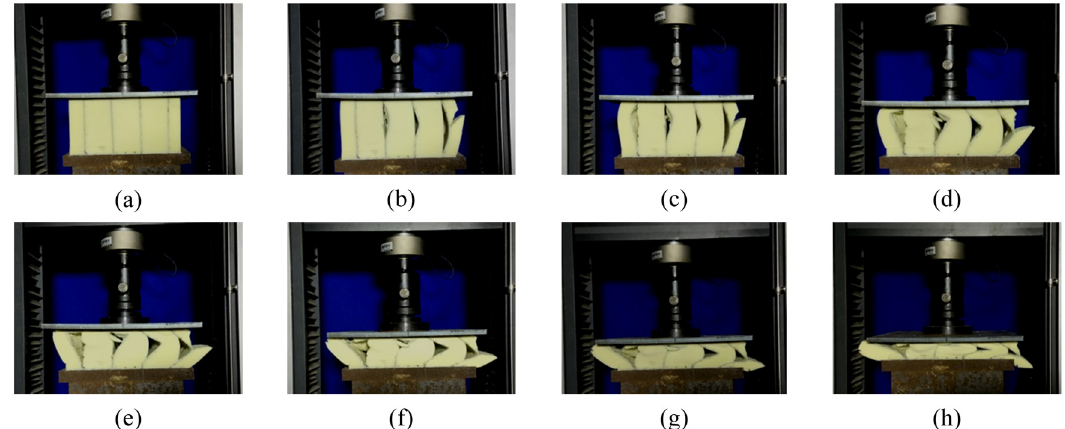
Figure 5: Quasi - static experiment of TS - T - V: ( a ) beginning, ( b ) Δ = 15 mm, ( c ) Δ = 30 mm, ( d ) Δ = 45 mm, ( e ) Δ = 60 mm, ( f ) Δ = 75 mm, ( g ) Δ = 90 mm and ( h ) Δ = 105 mm. ( Note: Δ represents the compression displacement )